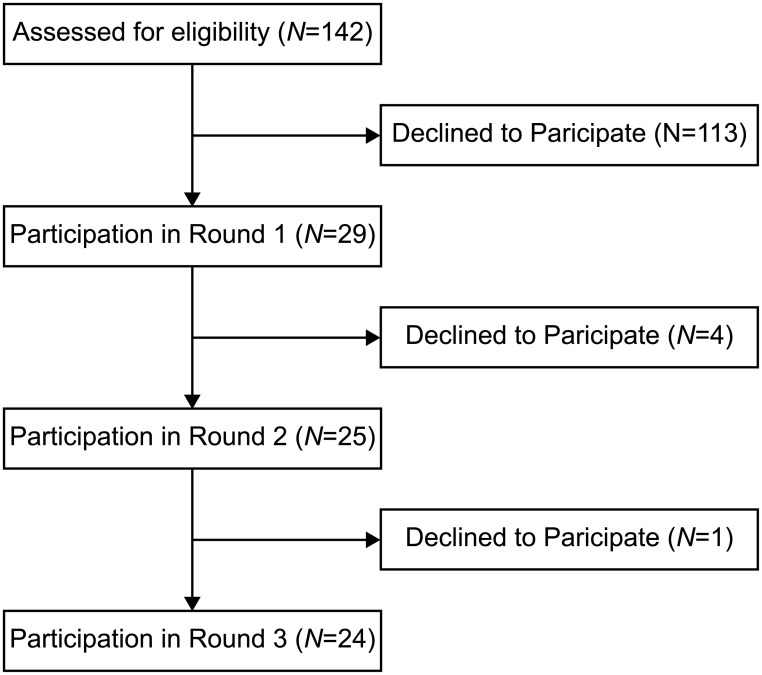
Participation in each round of this Delphi study.